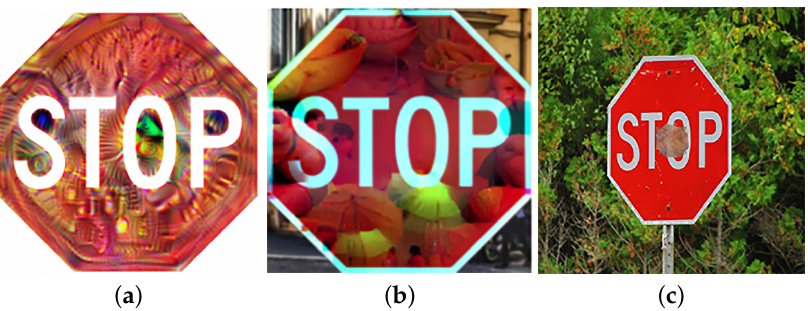
Figure 1. ( a , b ) show the suspicious appearance of camouflages generated by previous work, ( c ) shows the rust-style adversarial example generated by our method.